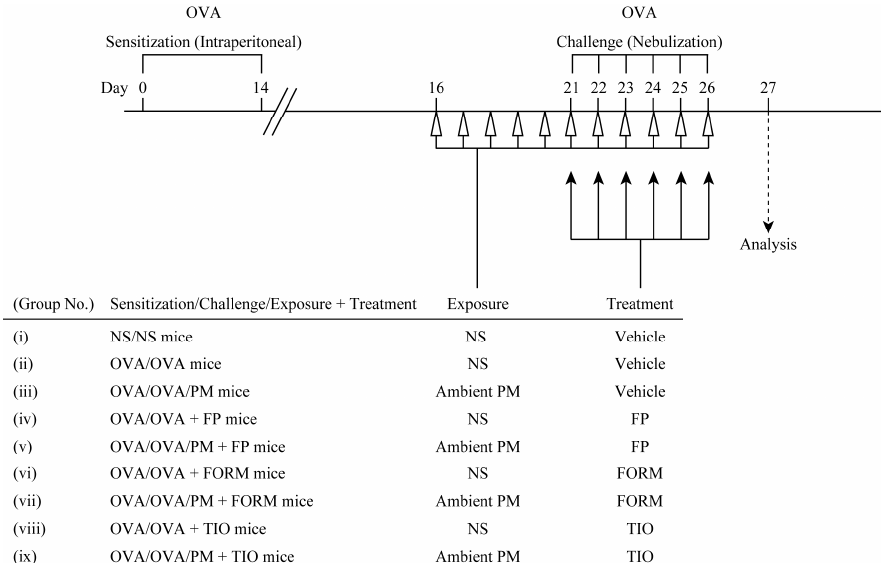
Figure 1. Experimental protocol of the mouse model of ovalbumin (OVA)-induced asthma used in the present study. For details, please see the text. FORM, formoterol fumarate; FP, fluticasone propionate; NS, normal saline; PM, particulate matter; TIO, tiotropium